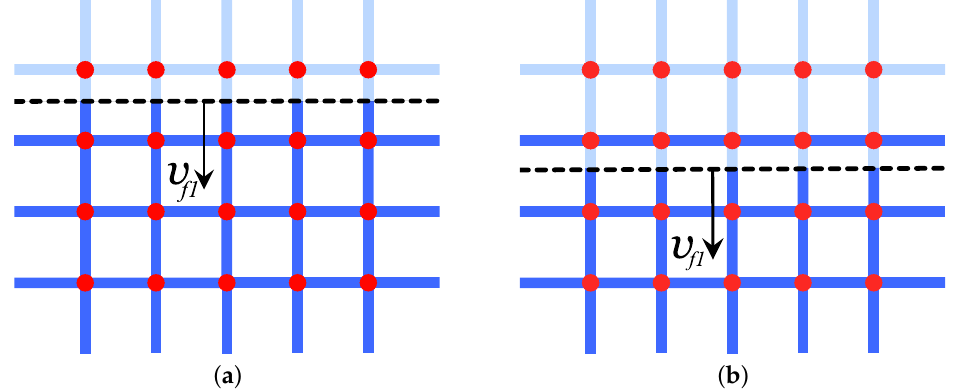
Figure 8. The network model and gas/liquid interface at t = 0 ( a ) and t = ∆ l / v f 1 ( b